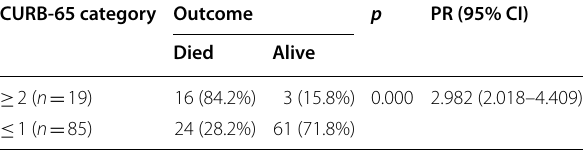
Table 1 Cross-tabulation of CURB-65 category to